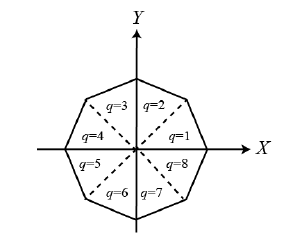
Figure 3. The octant number ( q ) for the model By computing q , points lying on other octants (the 2 nd , 3 rd , …, 8 th octant) can also be constrained by Equation (1) after rotating the points about Z-axis by the following angle